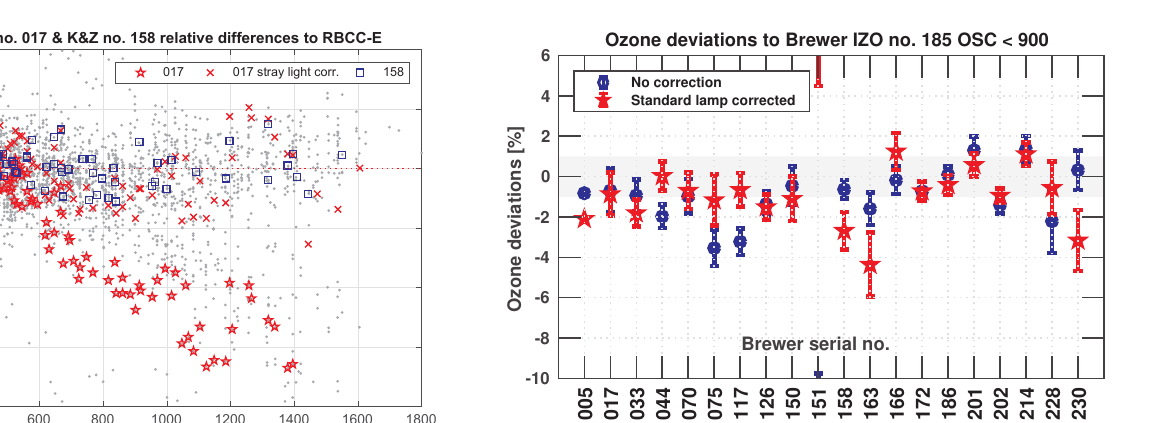
Figure 9. Comparison of reference instruments during the X RBCC-E campaign: relative differences with respect to the IZO ref- erence using the initial configuration during the campaign, in red for the IOS Brewer no. 017 (stars are used for the original observa- tions and crosses for the stray light corrected ones), and in blue for the Kipp & Zonen (K&Z) Brewer no. 158. The gray points are the relative differences to the IZO reference for all participating instru- ments